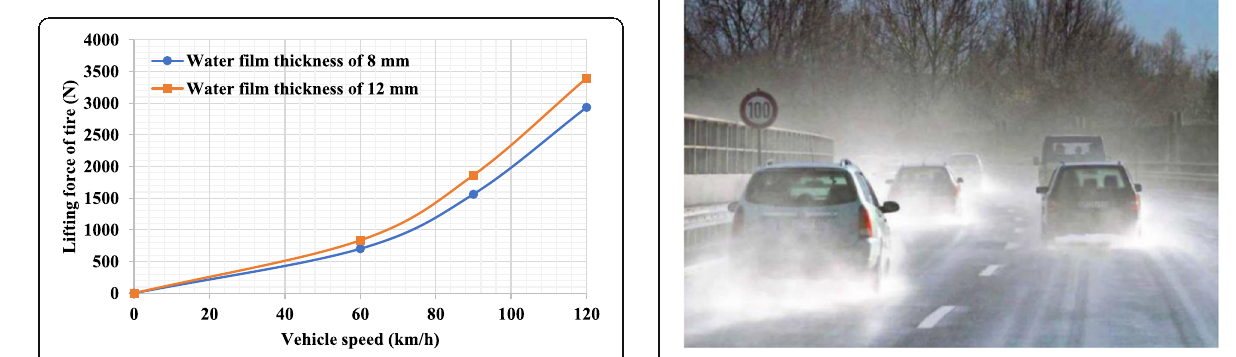
Fig. 7 Relation between lifting force and vehicle speed [47] Fig. 8 Water mist splashed by vehicle